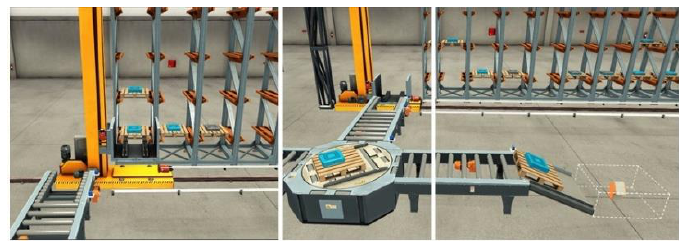
Figure 12. The discharge mode including HMI and warehouse scene.